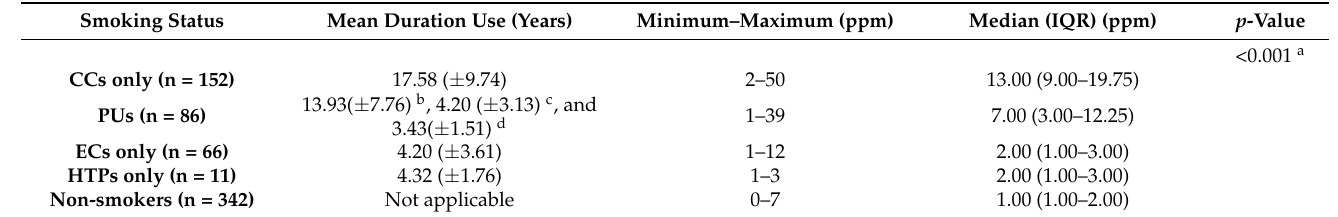
Table 3. Comparison of exhaled CO level according to different group of products used and current